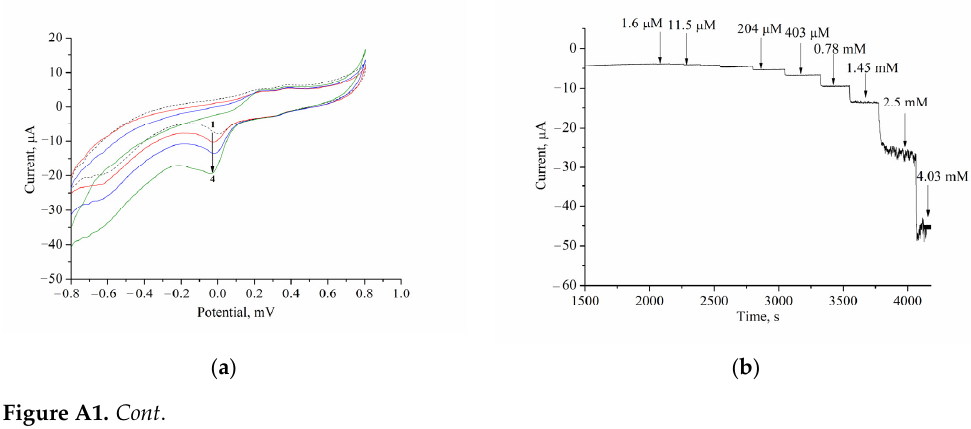
( d ) Figure A1. Amperometric characteristics of nCuCe/GE as a chemosensor of H 2 O 2 . ( a ) CV profiles as current responses upon addition of analyte up to concentrations (mM): 0 (1, black); 2.5 (2, red); 5.0 (3, blue); 10 (4, green). ( b , c ) chronoamperometric response and dependence of amperometric signal on concentration of H 2 O 2 , respectively; ( d ) calibration graph for H 2 O 2 determination. Conditions: